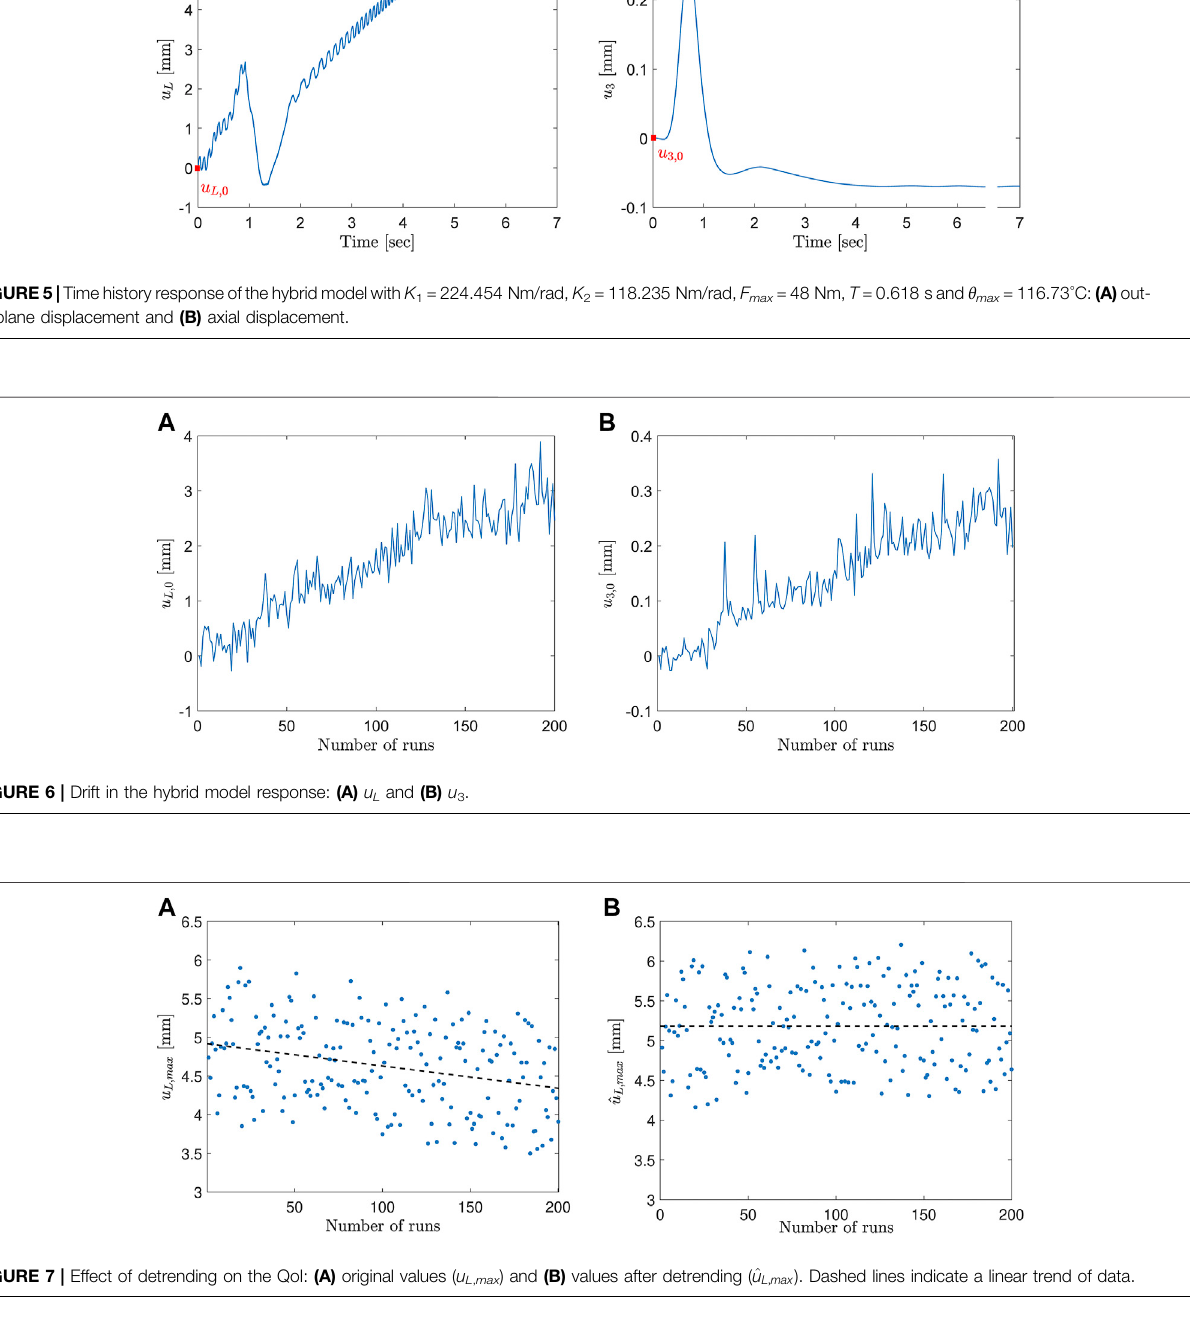
Frontiers in Built Environment |